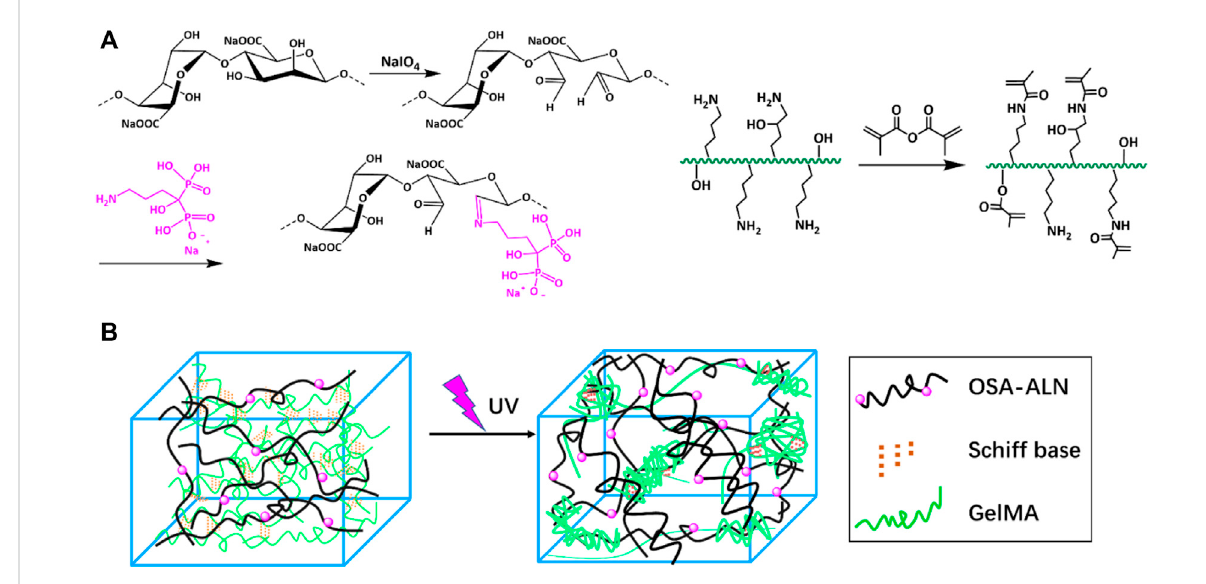
FIGURE 1 Schematic illustration. (A) Synthesis route of the OSA-ALN polymer, GelMA polymer and (B) the preparation of GelMA@OSA-ALN